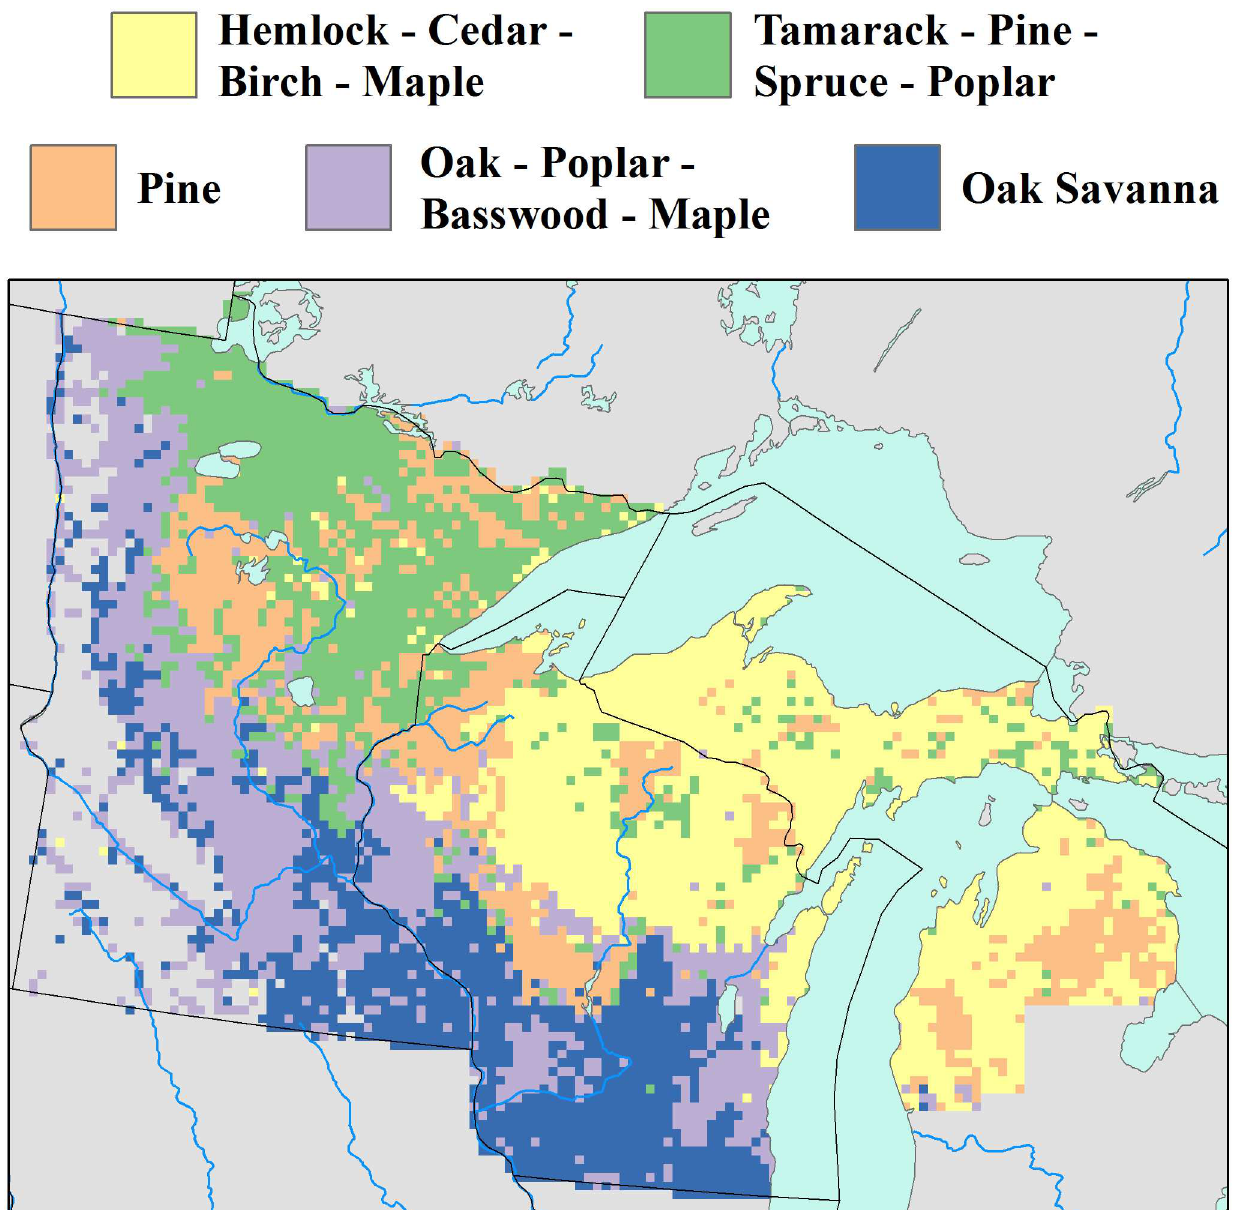
Fig 5. The five dominant forest types in the Upper Midwest as defined by k-medoid clustering. Forest types (from largest to smallest) includeHemlock-Cedar-Birch-Maple (yellow),Oak-Poplar-Basswood-Maple (light purple), Tamarack-Pine-Spruce-Poplar (light green), Oak Savanna (dark purple)and Pine (orange). These forest types represent meso-scale(64km 2 ) forest associations, rather than local-scale